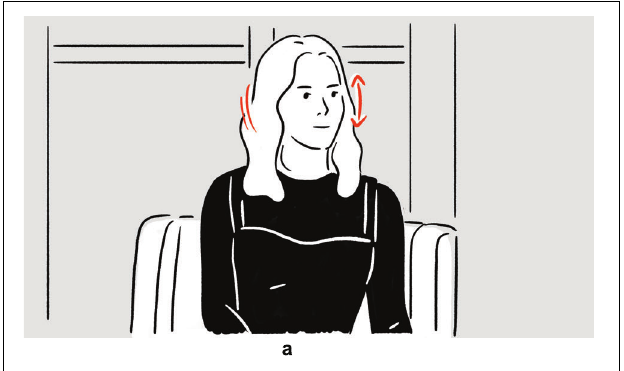
FIGURE 11 | Depiction in